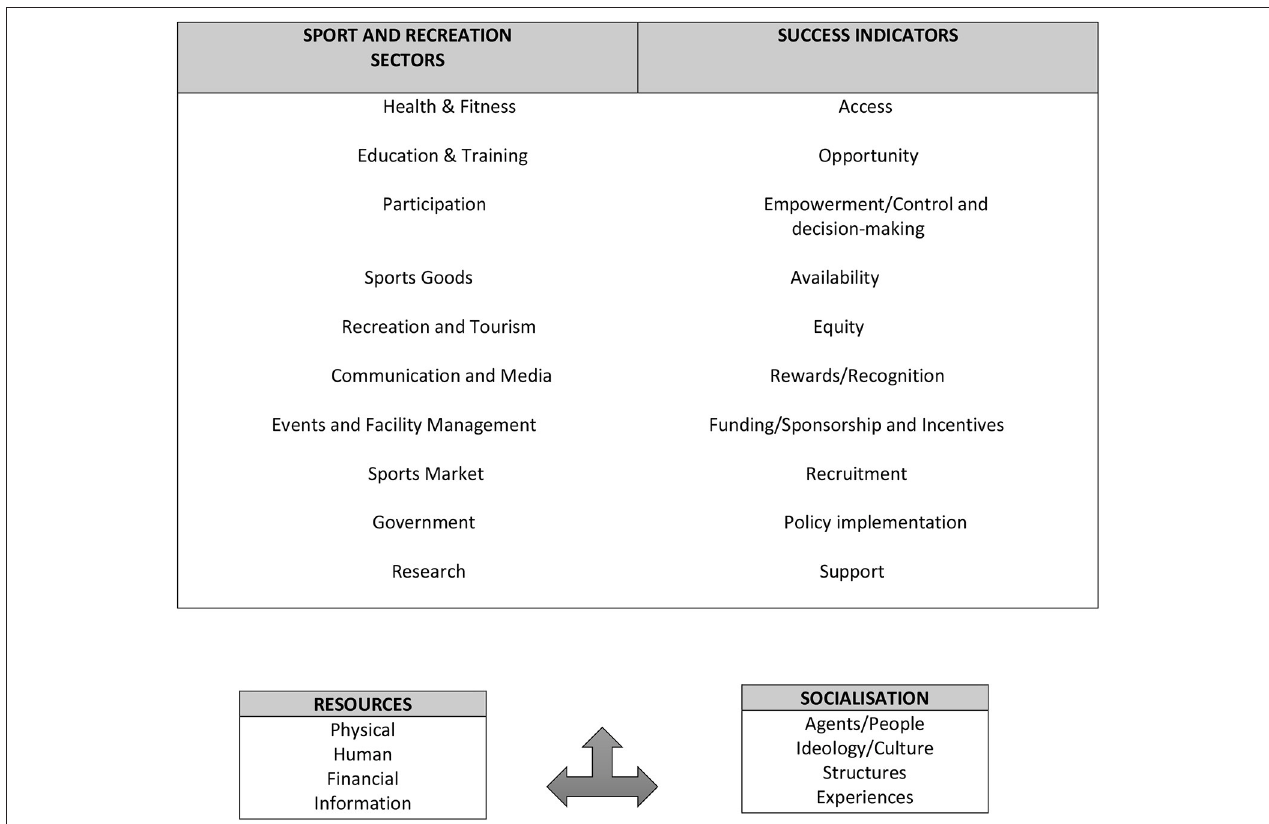
FIGURE 1 | Components impacting on experiences of women in sport and recreation sectors (Burnett, 2004, p.